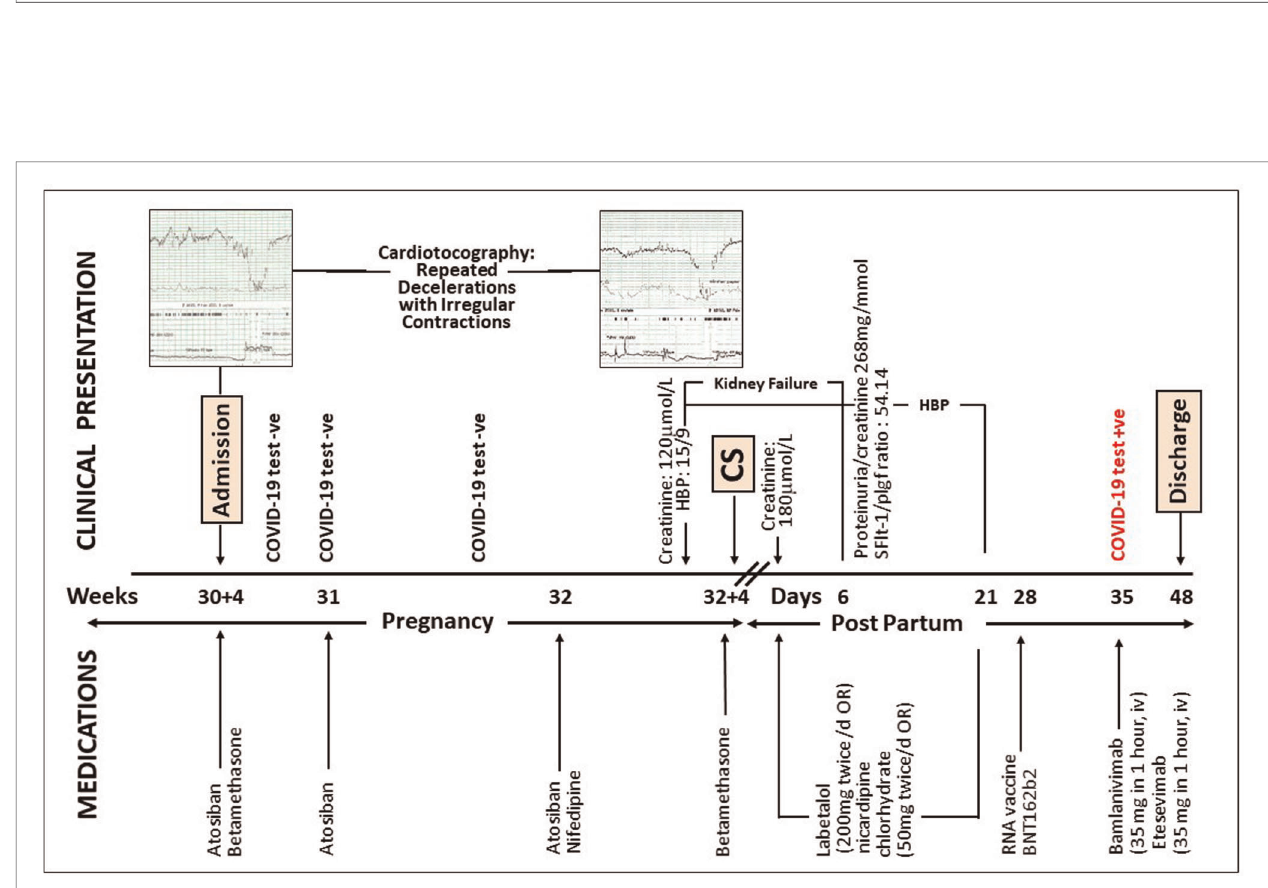
FIGURE 3 | Timeline of clinical presentation and medications during pregnancy and post-partum hospitalization. HBP, High blood pressure; OR, oral; − ve, negative; +ve, positive.